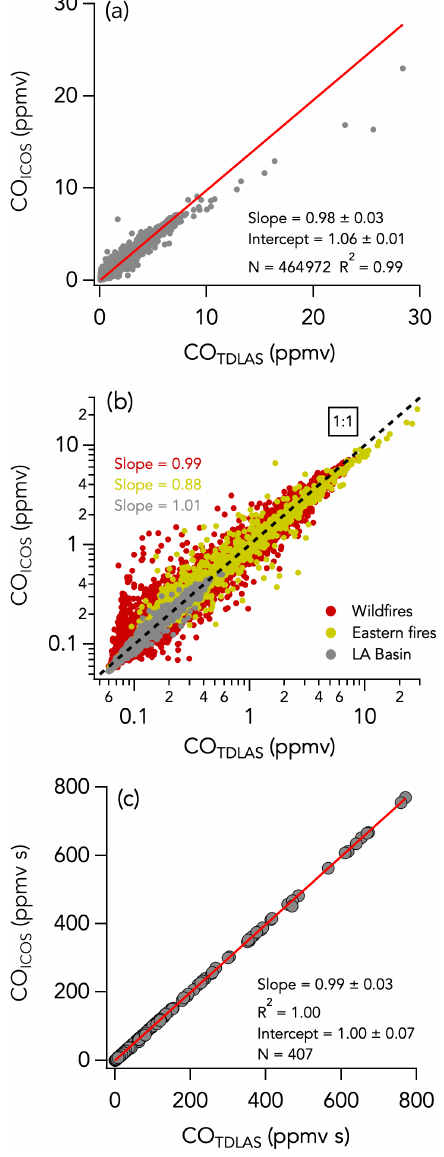
Figure 14. The same as Fig. 2 but comparing CO measurements by TDLAS and